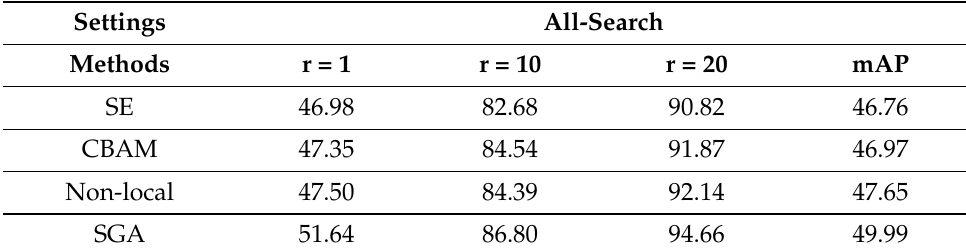
Figure 4. Feature Map Visualization. The picture shows two images of one identity. ( a ) uses IR images to search RGB image. ( b ) is the opposite Table 5. Comparison of different attention